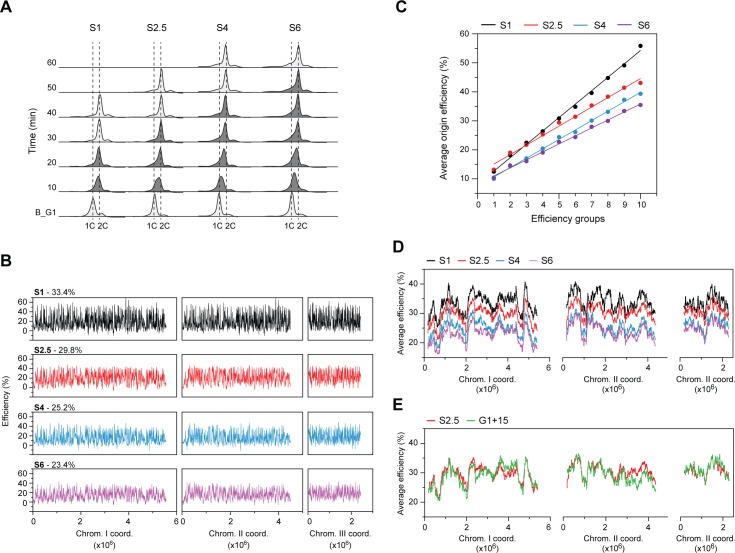
CDK activity is a dose-dependent regulator of genome-wide origin efficiencies.A) DNA content analysis of cells entering S phase with different concentrations of the 3-MBPP1 inhibitor. The experimental procedure was as in Fig 4A, except that cells were not treated with HU and were released into different concentrations of 3-MBPP1 after the 165 min G1 arrest (B_G1 as in Fig 4A). The 3-MBPP1 concentrations used were: S1–1 μM (data as for G1+165 in Fig 4); S2.5–2.5 μM; S4–4 μM; S6–6 μM. Samples in which cells are undergoing DNA replication are shown in dark gray. As mentioned for Fig 4A, the majority of the cells at the end of the 165 min G1 arrest have a 1C DNA content. Increasing concentrations of the inhibitor lead to prolongations of bulk S phase duration. See Materials and Methods for additional details for the interpretation of flow cytometry profiles. B) Origin usage profiles of S1 (black, data as in Fig 4C), S2.5 (red), S4 (blue), and S6 (purple). Experiments were performed as in Fig 4A (in the presence of HU) with release into the different inhibitor concentrations. Cells were harvested after S phase is completed in a sample without HU; this timing differs for each inhibitor treatment (see A and Materials and Methods). The overall average origin efficiencies for each condition are shown. x-axis: chromosome coordinates, y-axis: origin efficiencies. For full detailed profiles and one-to-one comparisons of origin efficiencies, see S5A and S5B Fig, respectively. C) Analysis of efficiencies in the different replication programs across the spectrum of origin activities. Origins were divided into 10 subsets containing similar numbers of origins based on their efficiencies in the S1 condition. Each point represents the average efficiency for each group. The line of best fit is shown for each CDK activity level. D) Regional profiles of replication domains in S1, S2.5, S4, and S6. The averages of origin efficiencies were determined in each condition for continuous windows of ~250 kb (1000 probes). Data for S1 are as in Fig 4D. x-axis: chromosome coordinates, y-axis: average origin efficiencies. E) Comparison of the replication domain profiles of G1+15 (data as in Fig 4D) and S2.5 (data as in D). The averages of origin efficiencies were determined for continuous windows of ~250 kb (1000 probes). x-axis: chromosome coordinates, y-axis: average origin efficiencies. Overall average efficiency of origins in G1+15: 29.4%, S2.5: 29.8%. For one-to-one comparisons of origin efficiencies, see S5E Fig.